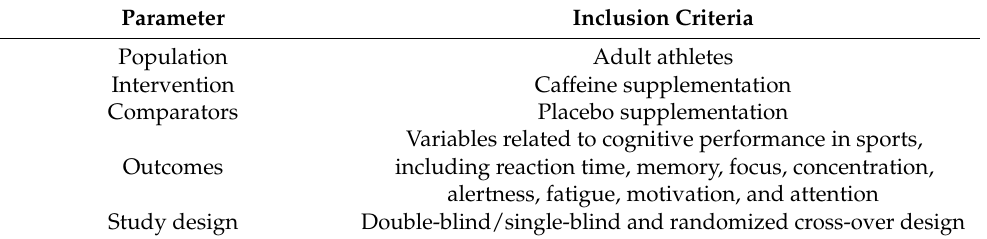
Table 1. PICOS criteria for the inclusion of studies in the systematic